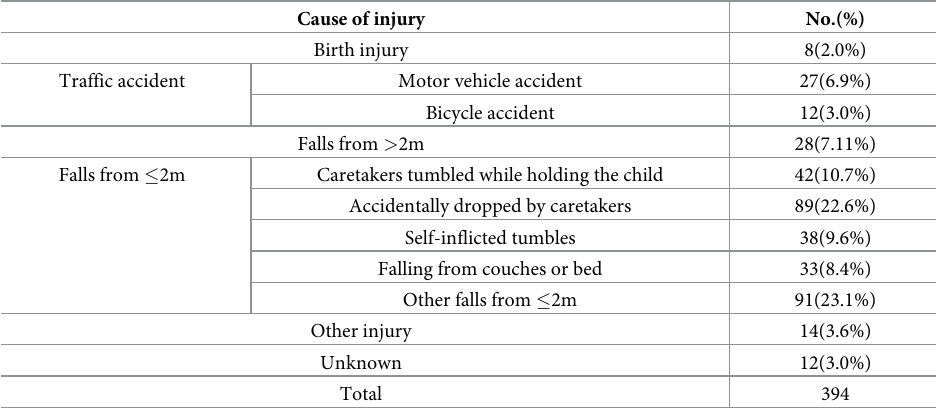
Table 3. List of cause of injuries in accidental